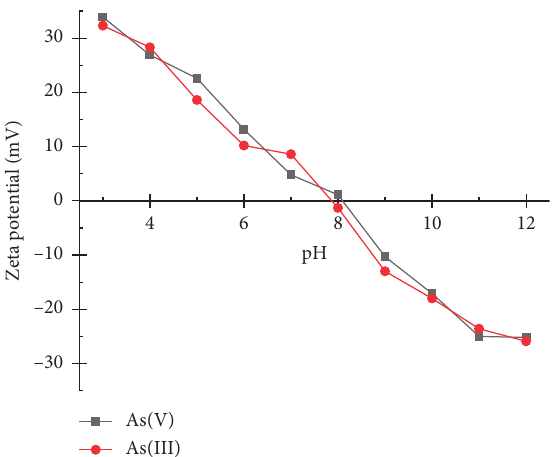
Figure 5: Zeta potential of nano-TiO 2 loaded as a function of pH with reaction conditions: initial concentration: As(III) 70 µ g/L and As(V) 84 µ g/L, solution volume 25ml, adsorbent dosage 0.05g, and ionic strength 0.01